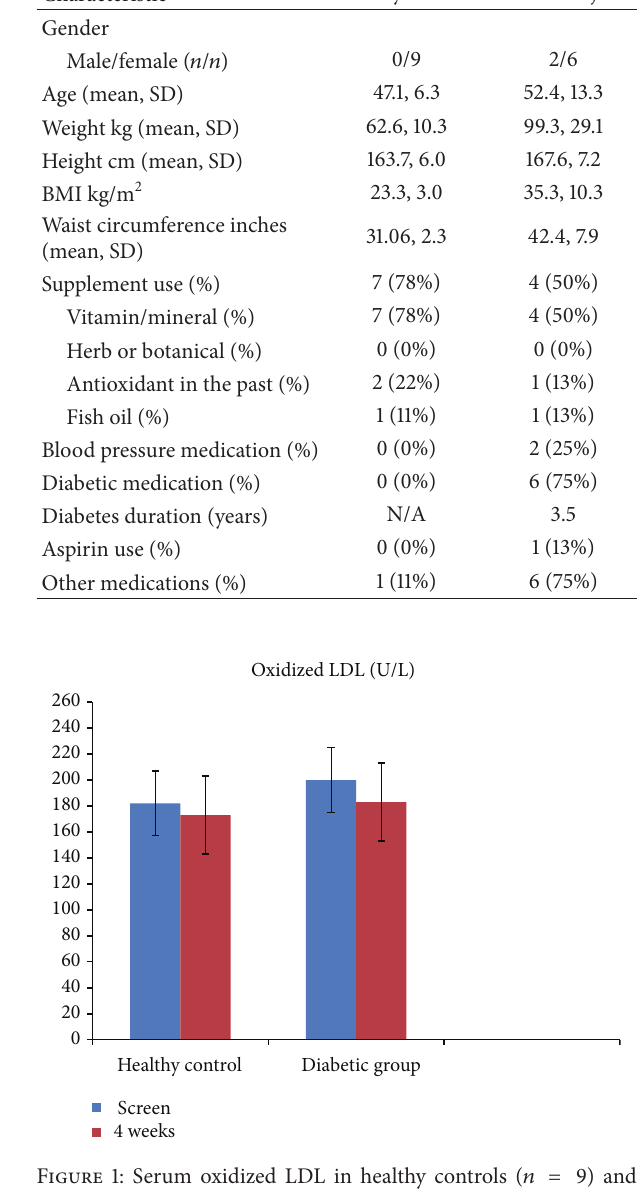
Figure 1: Serum oxidized LDL in healthy controls ( 𝑛 = 9 ) and in patients with type 2 diabetes ( 𝑛 = 8 ) before and after (4 weeks) pomegranate polyphenol supplementation. Data presented as mean ±